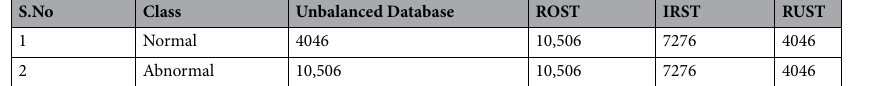
Table 2. Comparison of number of samples in the classes in balanced PTBDB ECG database with number of samples in the classes in unbalanced PTBDB ECG